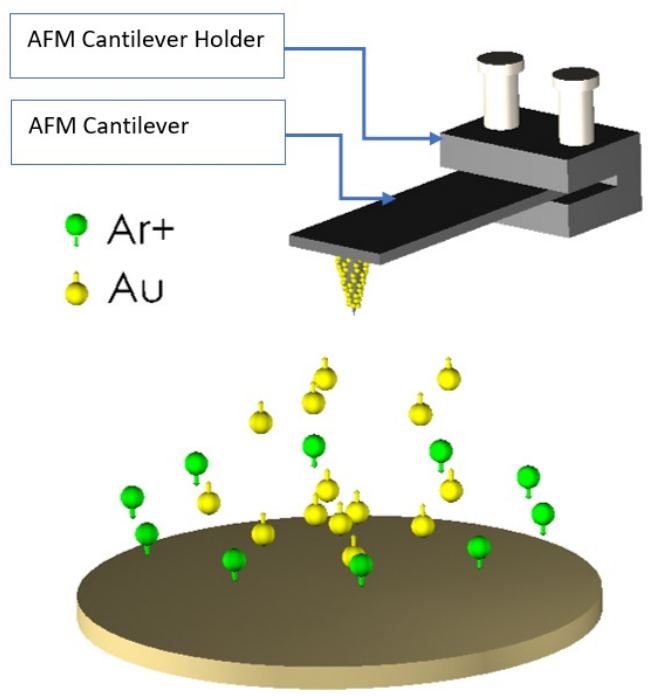
Figure 2. Schematic image of the magnetron sputtering method to deposit Au on AFM cantilever